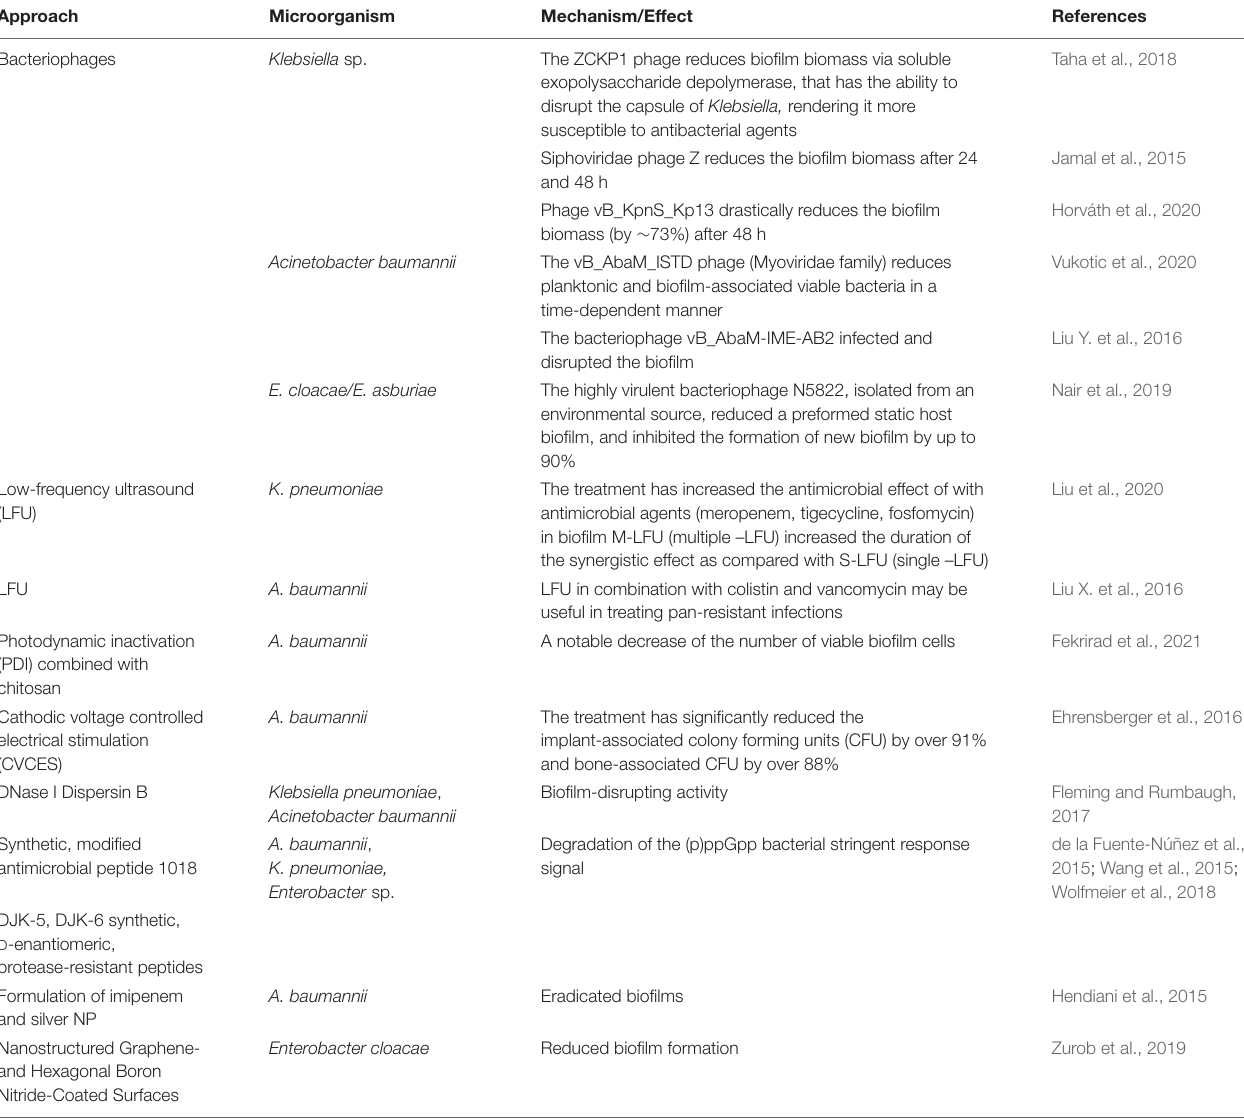
TABLE 3 | Recent approaches for BAIs management in A. baumannii, Klebsiella sp., and Enterobacter